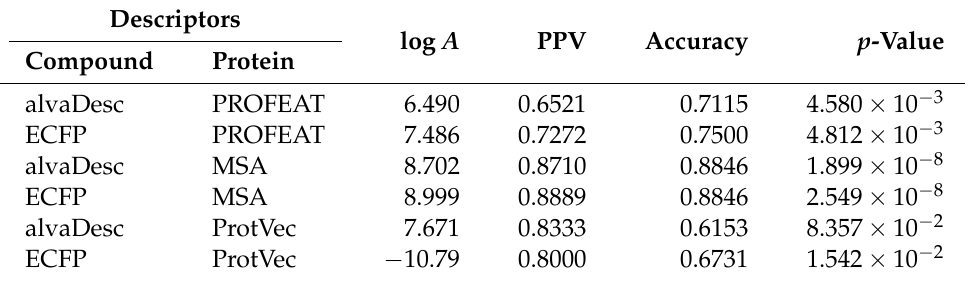
Table 5. Accuracy of predicting GPCRs with an AUROC of 0.8 or higher using the applicability index for six different combinations of compound and protein descriptors. The log A column is the threshold of the applicability index, PPV is the positive predictive value, Accuracy is the prediction accuracy, and p -value is the result of Fisher’s exact